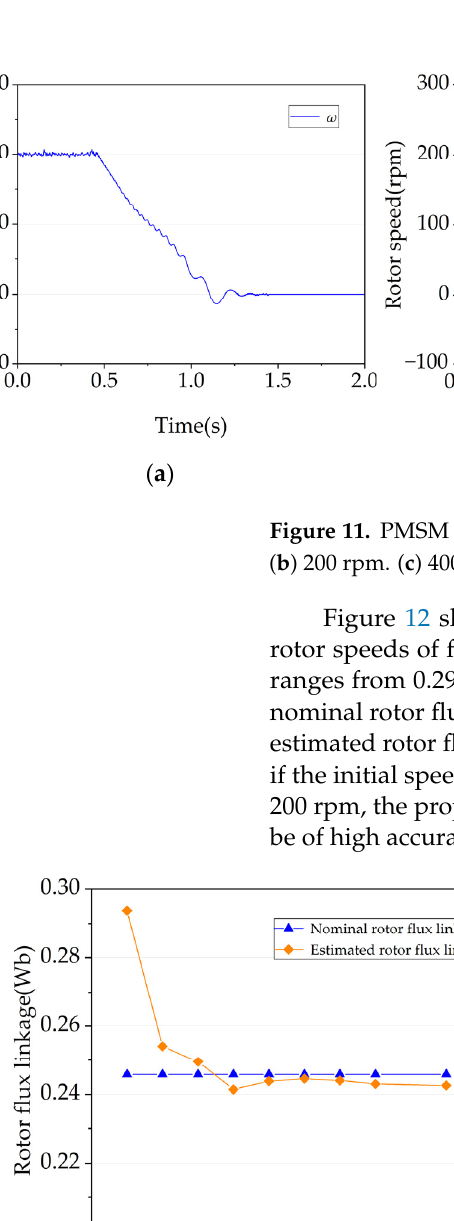
( b ) Figure 10. Comparison between estimated and measured rotor flux linkage under different PM tem- peratures. ( a ) Estimated/measured rotor flux linkage; ( b ) variation in the rotor flux linkage. 4.3. Estimation under Free-Running Condition Figure 11 shows the free running test starting from different initial speeds, which settle down to zero finally. The duration from the initial speed to zero is defined as the time of free-running. It is worth noting that a higher initial speed of PMSM will result in a longer settling time. The data lengths Data 3 and Data 4 for the estimation of rotor flux linkage are both set to 0.3 s at different initial speeds. However, as can be seen from Figure 11a, the duration of free-running is less than 1 s at 100 rpm. During a period of time when the rotor speed is close to zero, the rotor speed oscillates greatly, which leads to the pos- sibility of invalid data. Hence, on condition that the duration of free-running is too short, it will become difficult to obtain enough data for the estimation of rotor flux linkage. Figure 12 shows the estimated rotor flux linkage by using (19) at different initial rotor speeds of free-running. It can be seen that the online-estimated rotor flux linkage ranges from 0.2938 Wb at 100 rpm to 0.2425 Wb at 1000 rpm. Thus, compared with the nominal